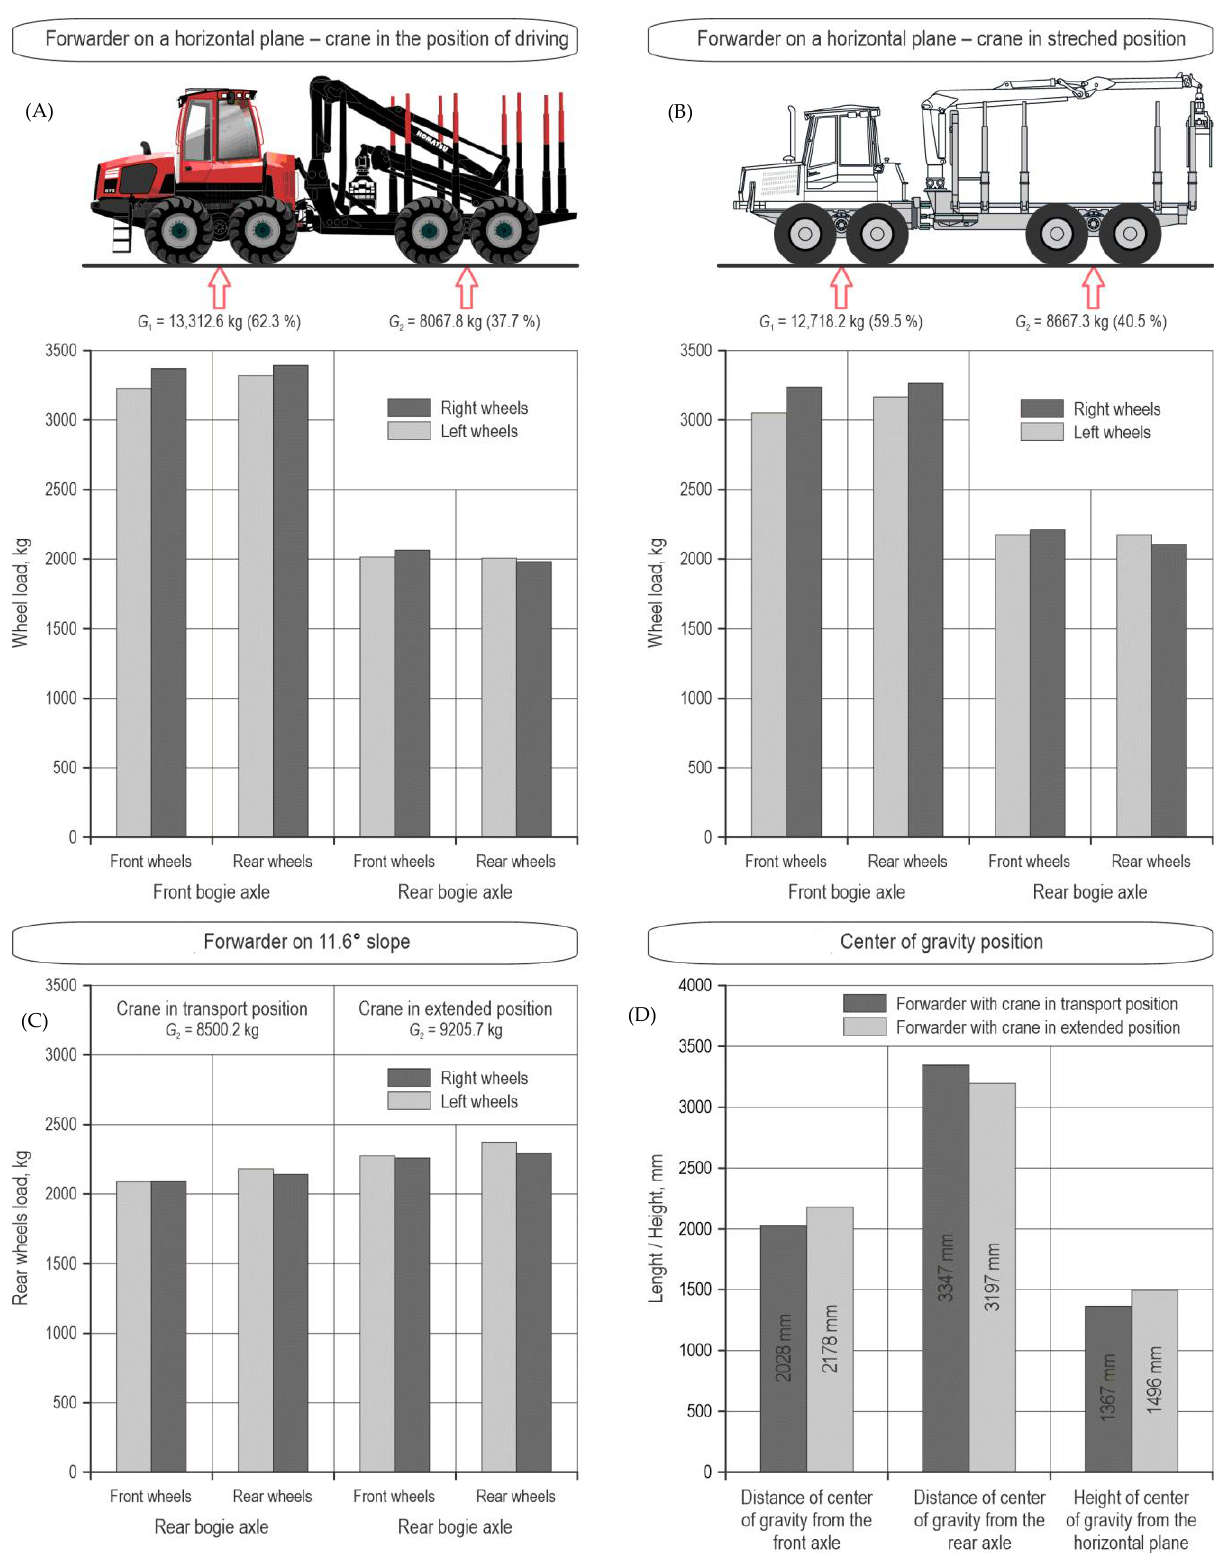
Figure 4. Wheel loads on a horizontal plane and slope and centre of gravity position — empty Komatsu 875.